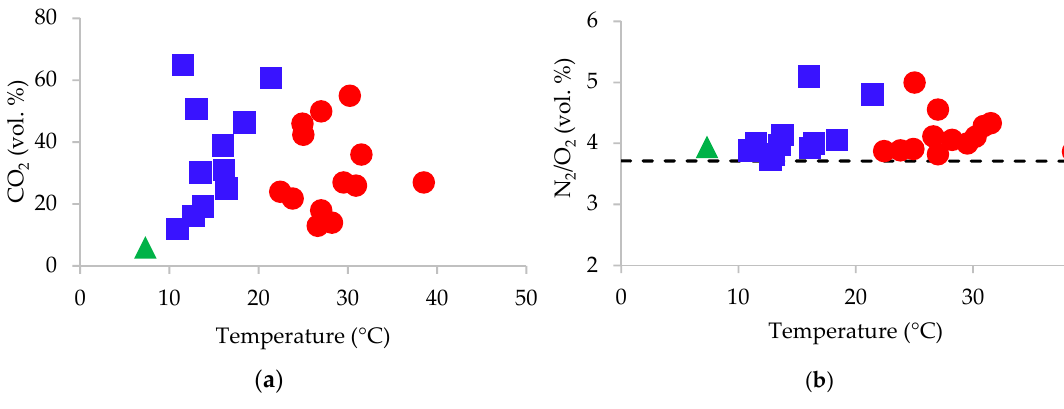
Figure 6. ( a ) CO 2 (vol.%) and ( b ) N 2 /O 2 ratio in gas composition of the studied waters vs. temperature (°C). Symbols are the same as for Figure 3. Dashed line is the N 2 /O 2 ratio in the air.